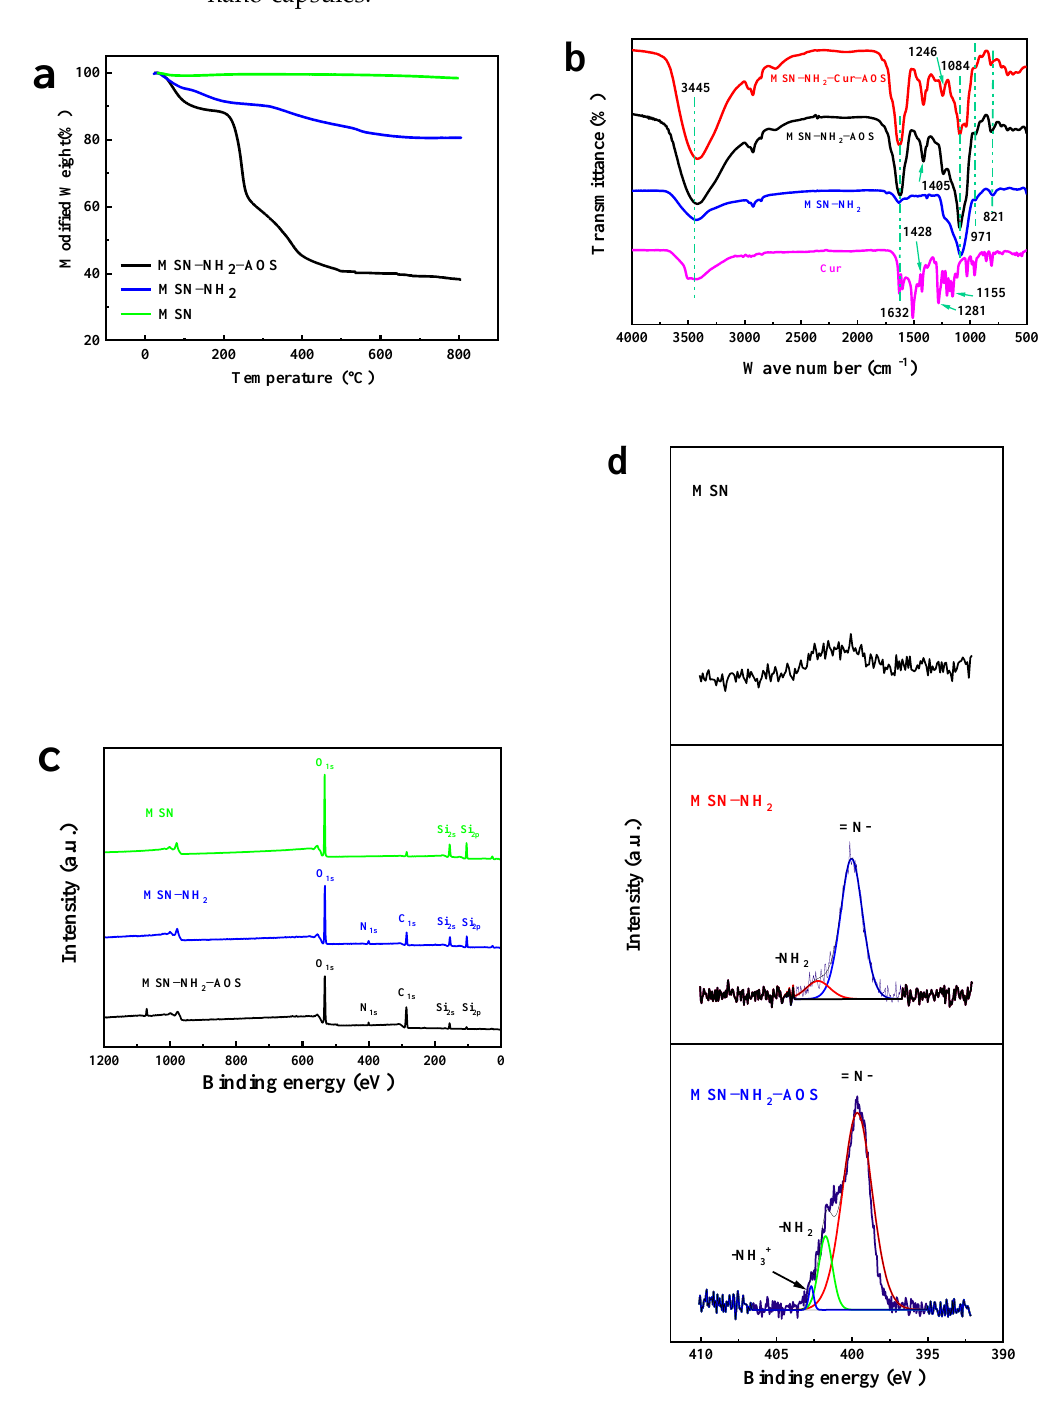
Figure 8. TGA of the nanoparticles ( a ). FTIR of the nanoparticles ( b ). XPS full spectrum of MSN, MSN-NH 2 , and MSN-NH 2 -AOS ( c ). N 1s spectrum of MSN, MSN-NH 2 , and MSN-NH 2 -AOS ( d ). Figure 8b shows the infrared spectra of Cur, MSN-NH 2 , MSN-NH 2 -AOS, and MSN- NH 2 -Cur-AOS nanoparticles obtained using FTIR. MSN characteristic peaks can be ob- served for MSN-NH 2 , MSN-NH 2 -AOS, and MSN-NH 2 -Cur-AOS, and the absorption peaks at 821, 971, and 1084 cm −1 were the three main absorption peaks of MSN. The peaks